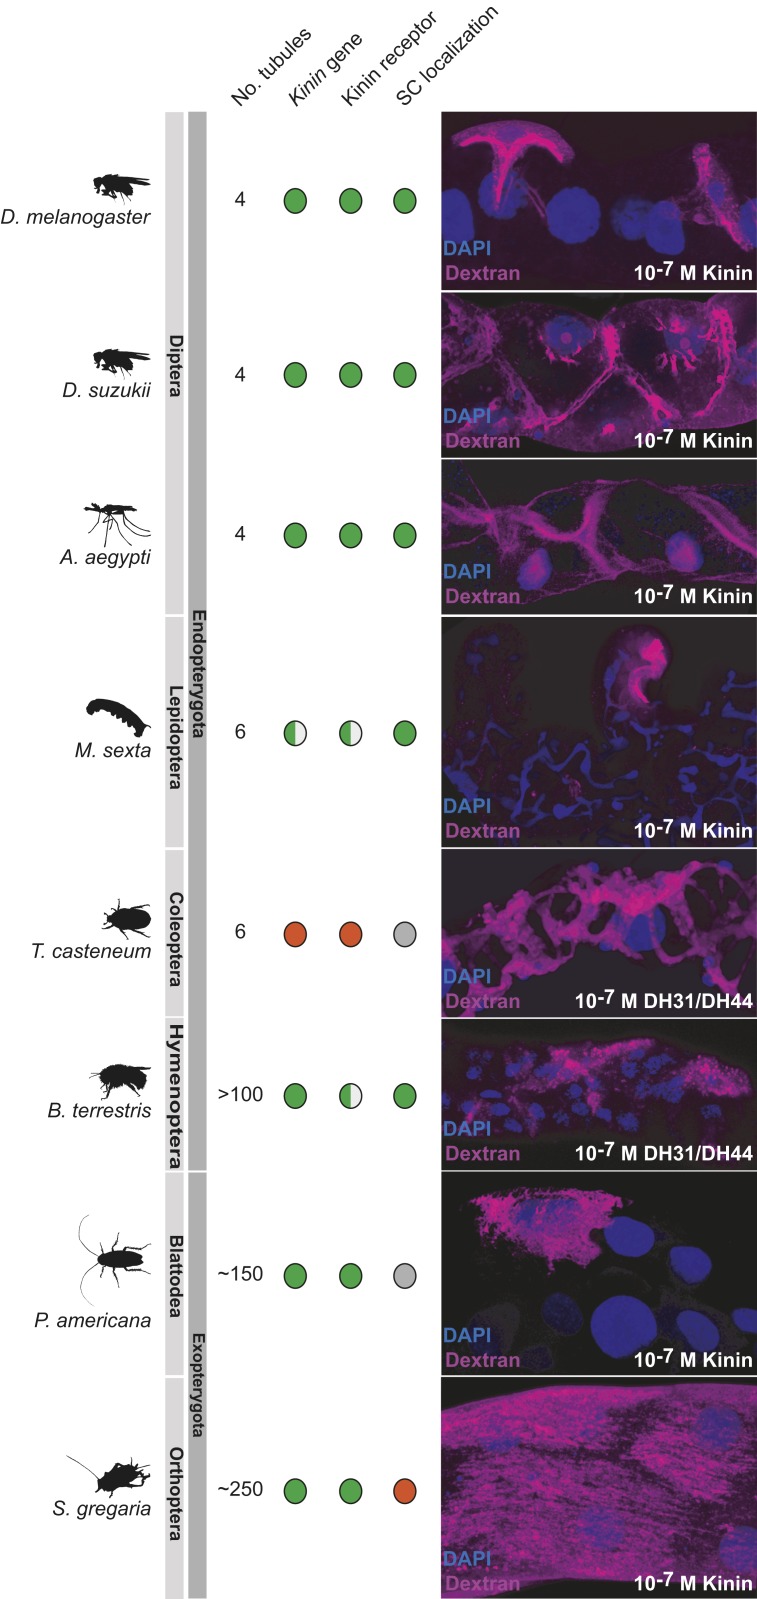
Dextran labeling as a tool to probe insect biodiversity. The dextran labeling protocol employed for D. melanogaster was applied to other insect species, selected from the major insect orders of exopterygotes and endopterygotes. The distribution of known stellate cells and Kinin labeling (diagnostic of the route of chloride shunt conductance) is adapted from ref. 51; green denotes positive (gene is present, or kinin receptor localization confined to stellate cells); red denotes absence, and gray denotes not known or ambiguous. In all species, the main region [in Manduca, the distal ileac plexus (67, 68)] of the tubule is shown.